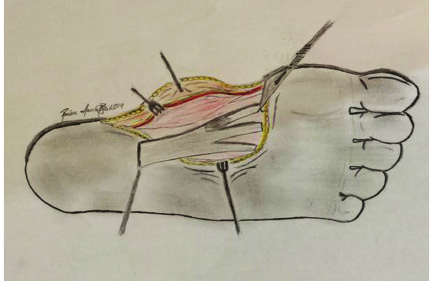
Figure 14: Schematic drawing of the division of the fascial exten- sionstothetoes.Careshouldbetakentoprotecttheemergingdigital nerves as they cross these